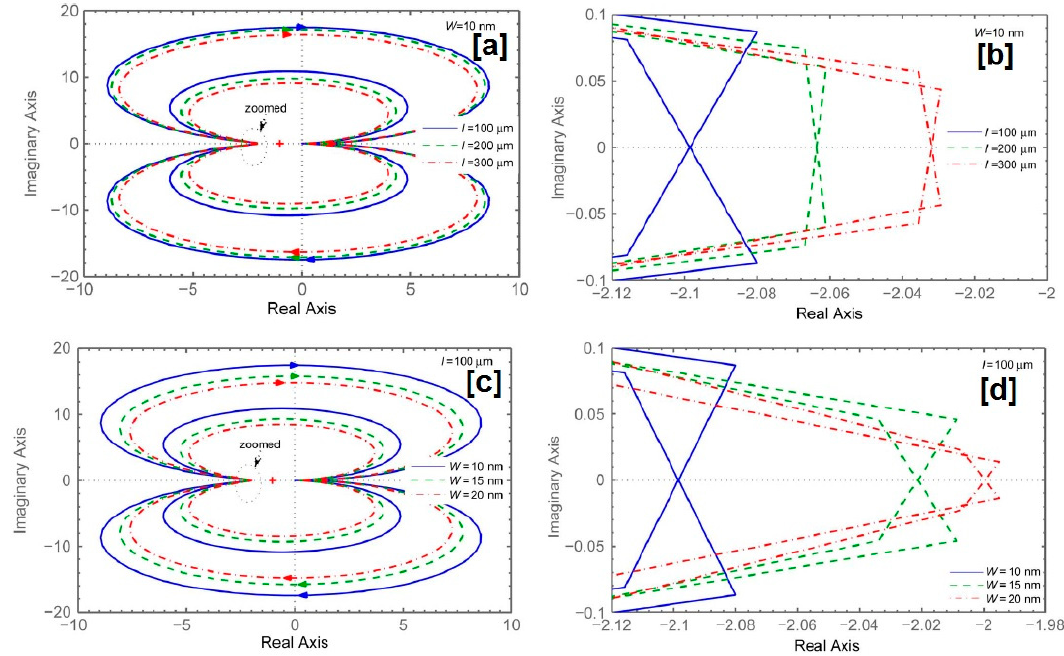
Figure 23. Nyquist diagrams for the distributed RLC model of MLGNR interconnect ( a ) for w = 10 nm and 100 µm ≤ l ≤ 300 µm; ( b ) zoomed in portion of the diagram ( a ) surrounded by the circle; ( c ) for l = 100 µm and 10 µm ≤ w ≤ 20 nm; ( b ) zoomed in portion of the diagram ( c ) surrounded by the circle [59]. Reproduced with permission from [59]. IEEE, 2010.